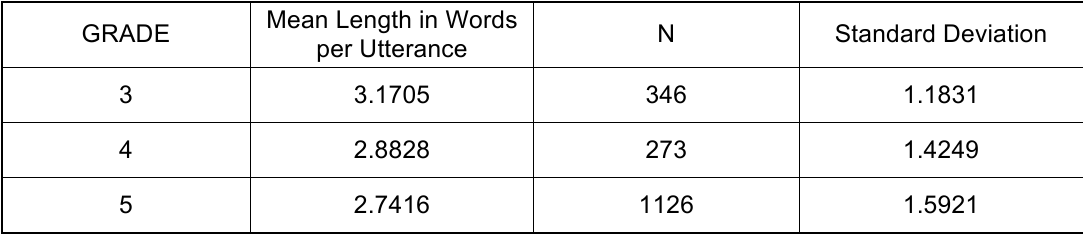
Table 1 Mean Length in Words GRADE per Utterance